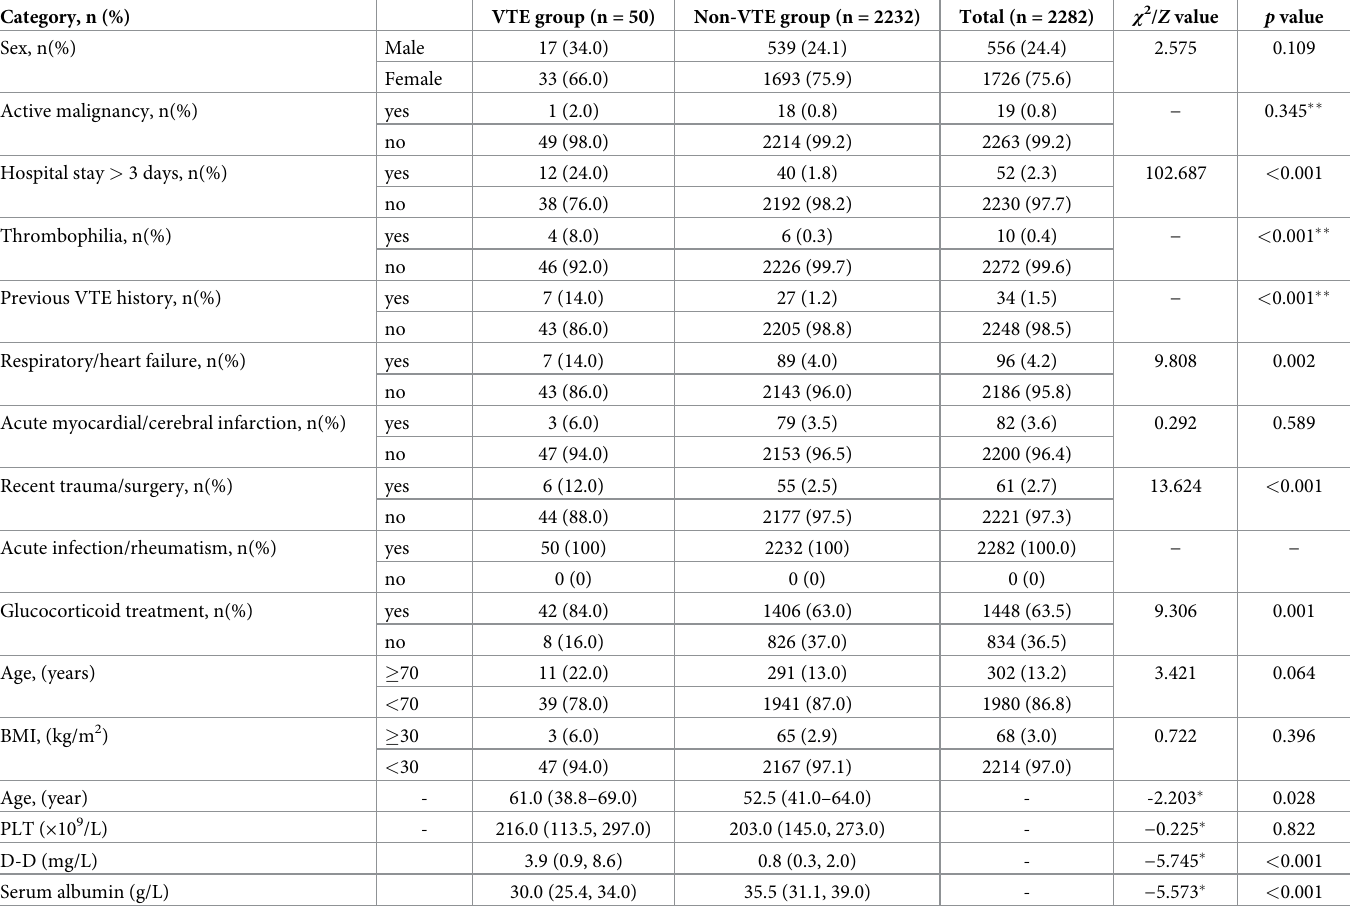
Table 3. Univariate analysis for VTE among the hospitalized rheumatic patients (n = 2282). Category, n (%)